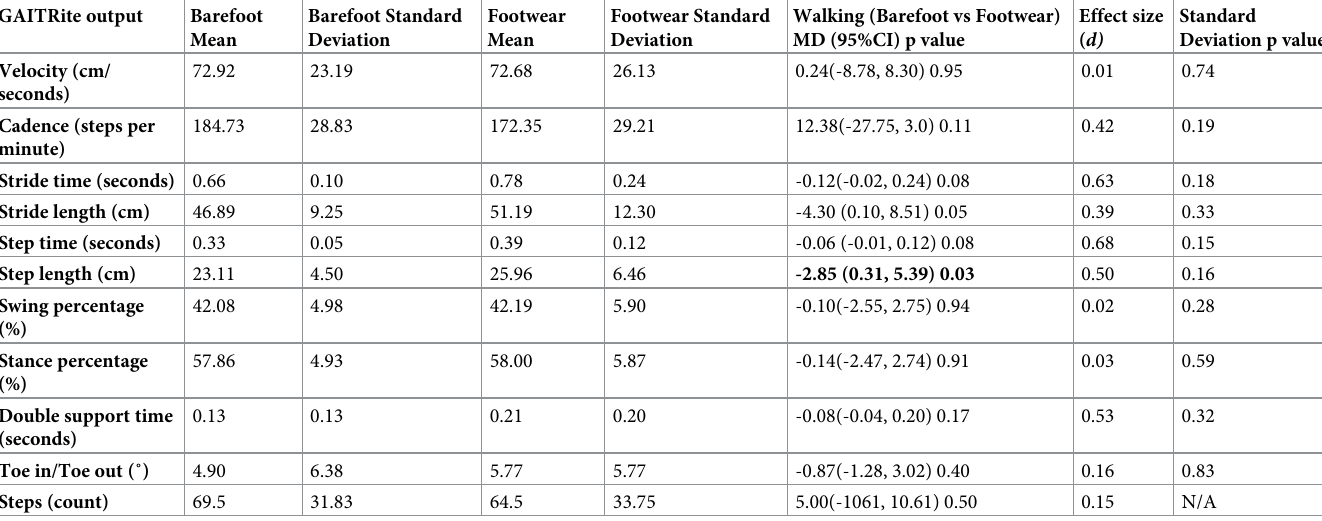
Table 1. Spatiotemporal variables for barefoot and footwear conditions (right side